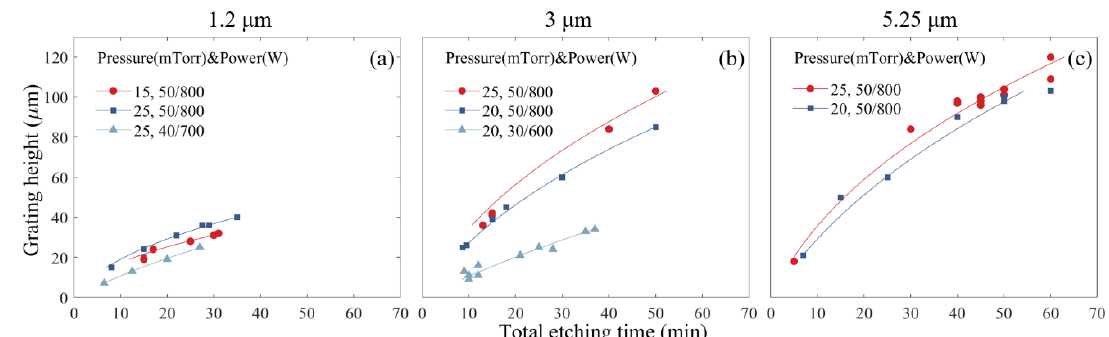
Figure 4. Grating height as a function of etching time for different grating periods: ( a ) 1.2 µm; ( b ) 3 µm; ( c ) 5.25 µm. The dots are raw experimental data, and the solid lines are best fits with modified Coburn–Winters model (Equation (5)).